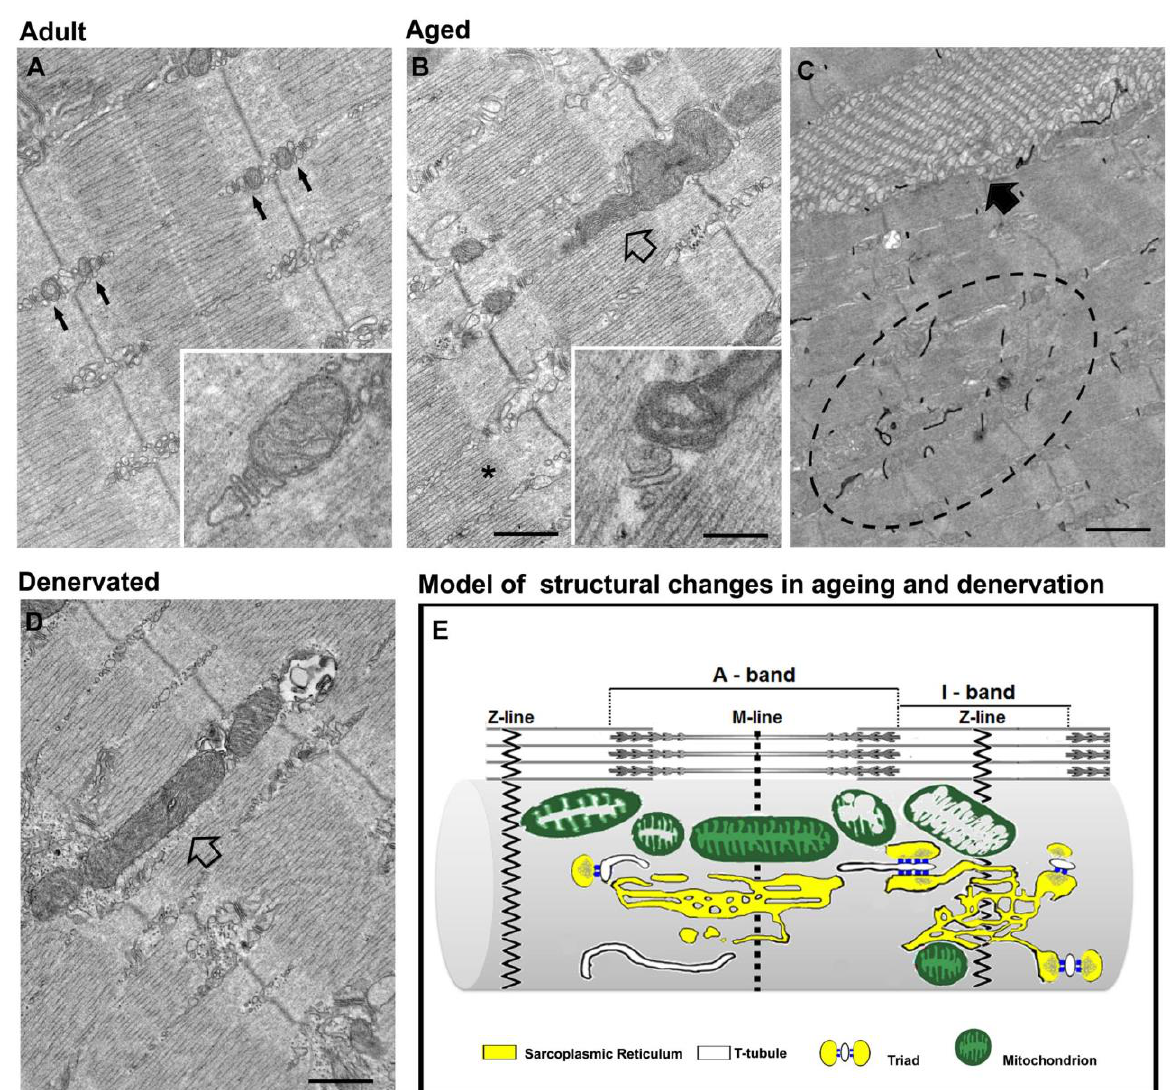
Figure 3. Disarray of intracellular organelles in denervation and ageing. (A – D ) Representative EM images of EDL muscle fibers from adult ( A ), aged ( B , C ) and denervated mice ( D ). Ageing and denervation cause a similar misplacement and damage of mitochondria ( B , D , empty arrows). In panel ( C ), a TA in ageing muscle (black arrow) and a disordered TT network (dashed oval), labelled in black with ferrocyanide, are shown. ( E ) A cartoon summarizing the main structural changes in ageing and denervation: loss of proper position of triads and mitochondria, and mitochondrial damage. Scale bar: ( A , B , D ) 0.5 μm; ( C ), 1 μm; insets, 0.1 μm.